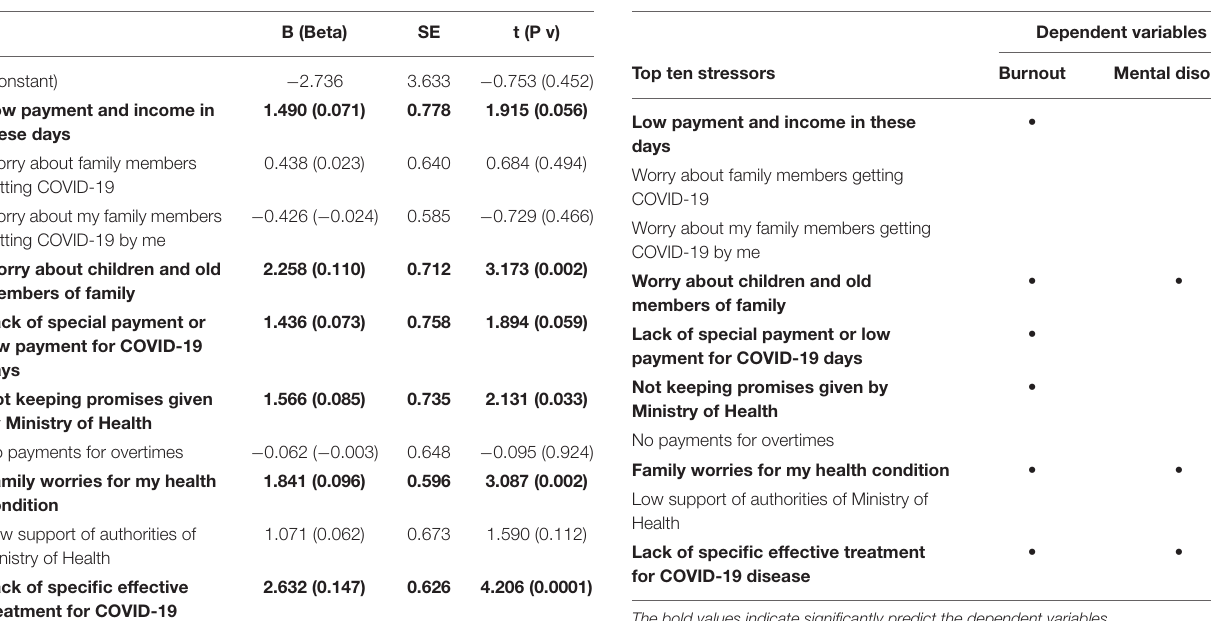
TABLE 7 | Summary of multiple regression analysis for top ten stressors predicting dependent